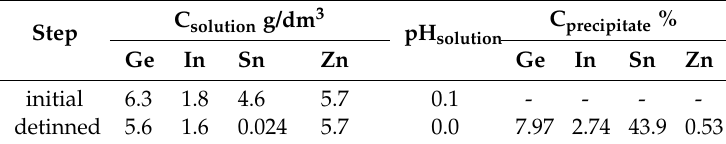
Table 3. Composition of the solution and precipitate before and after tin removal (70 ◦ C, 1 h, 6 cm 3 /dm 3 H 2 O 2 ).